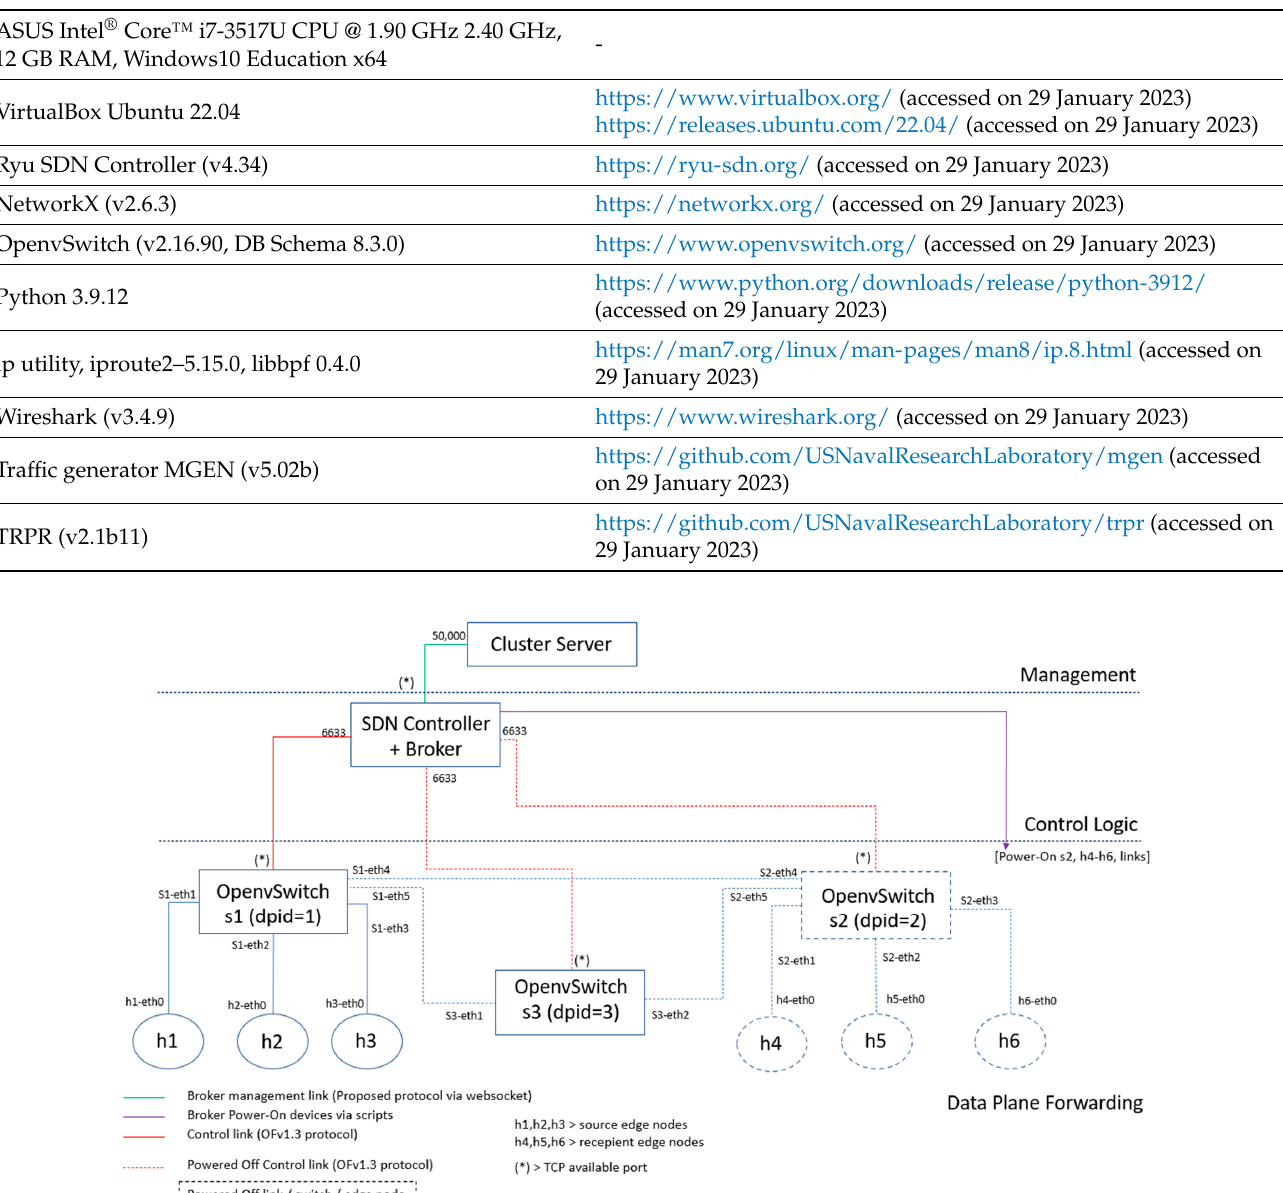
Table 2. Hardware and software tools used during the evaluation tests.